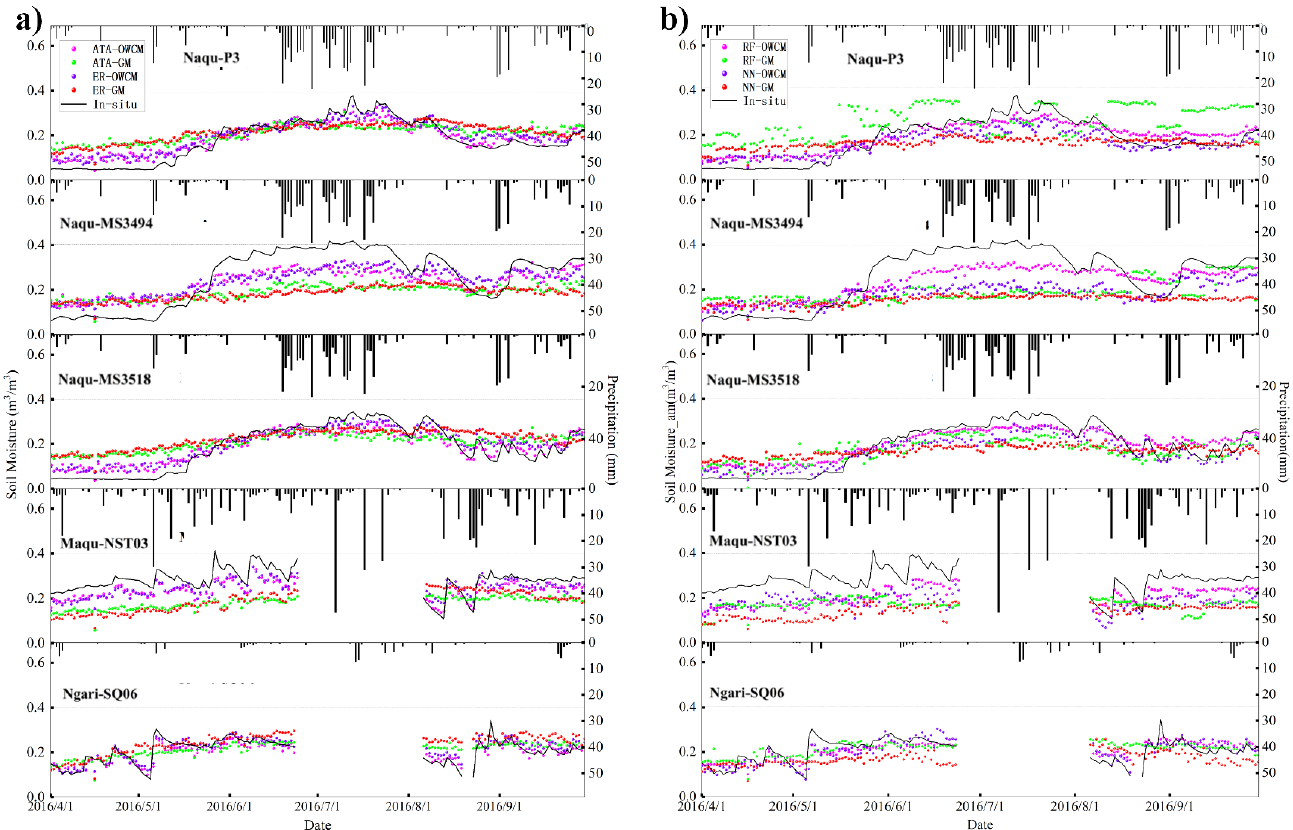
Figure 4. Time-series comparisons of daily GM-/OWCM-derived fine-RES SM with in situ SM measurements: ( a ) GM and OWCM results based on ATA and ER; ( b ) GM and OWCM results based on RF and NN.